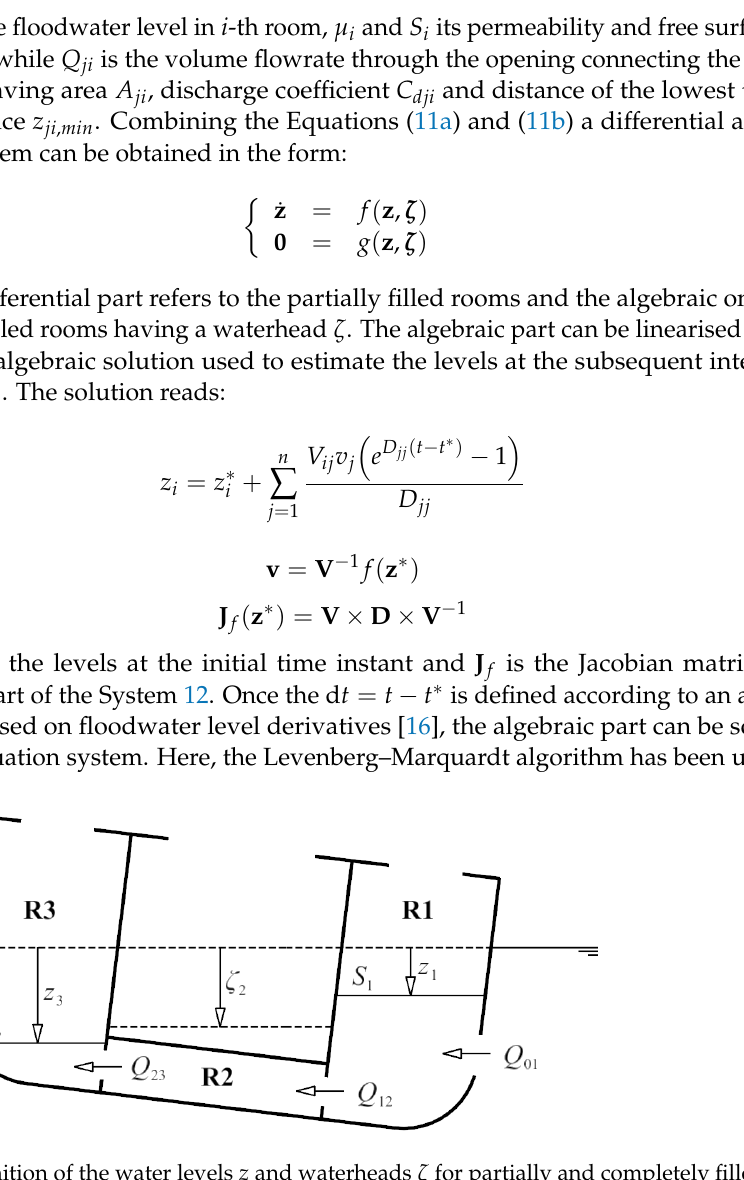
Figure 6. Definition of the water levels z and waterheads ζ for partially and completely filled rooms respectively